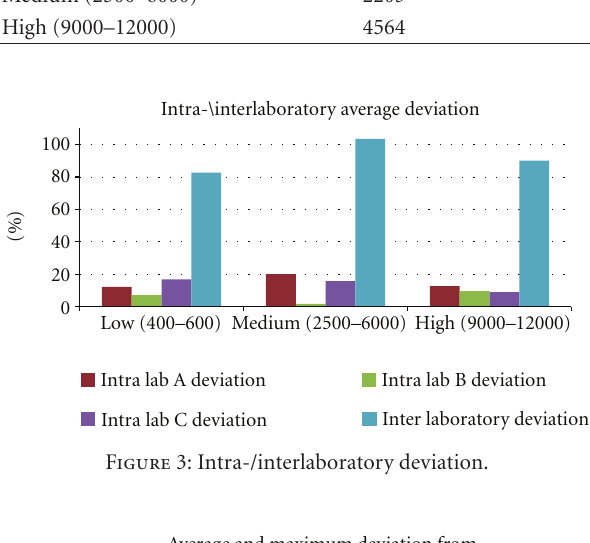
Figure 3: Intra-/interlaboratory deviation.